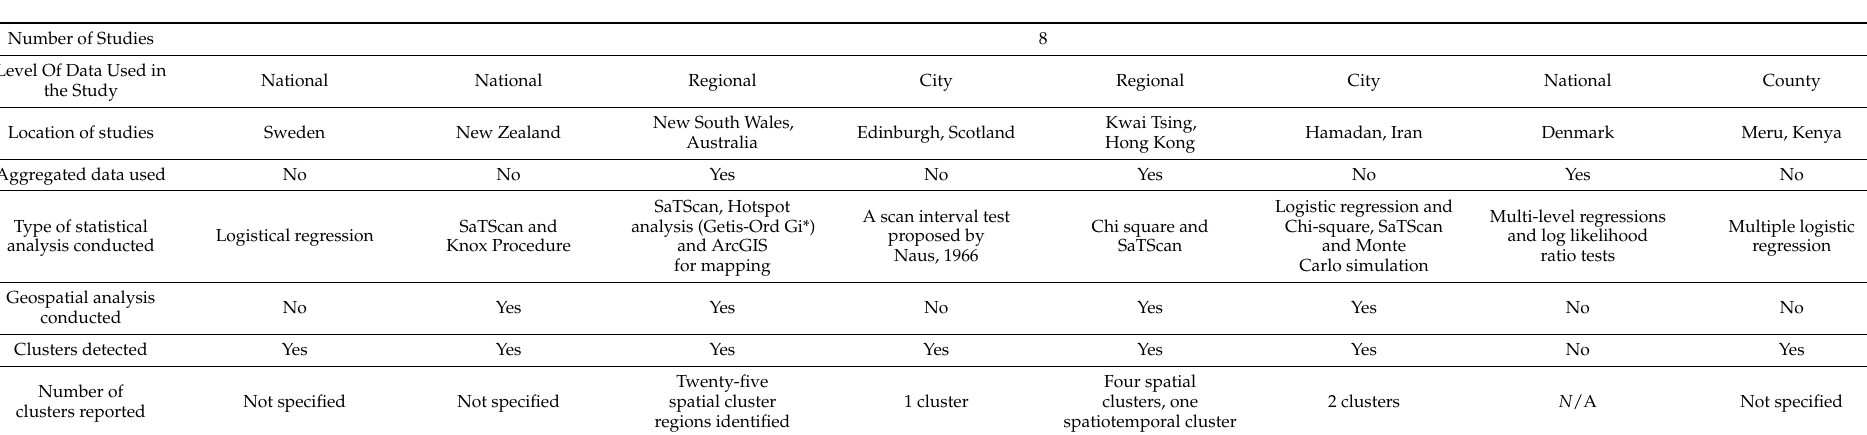
Table 2. Point self-harm